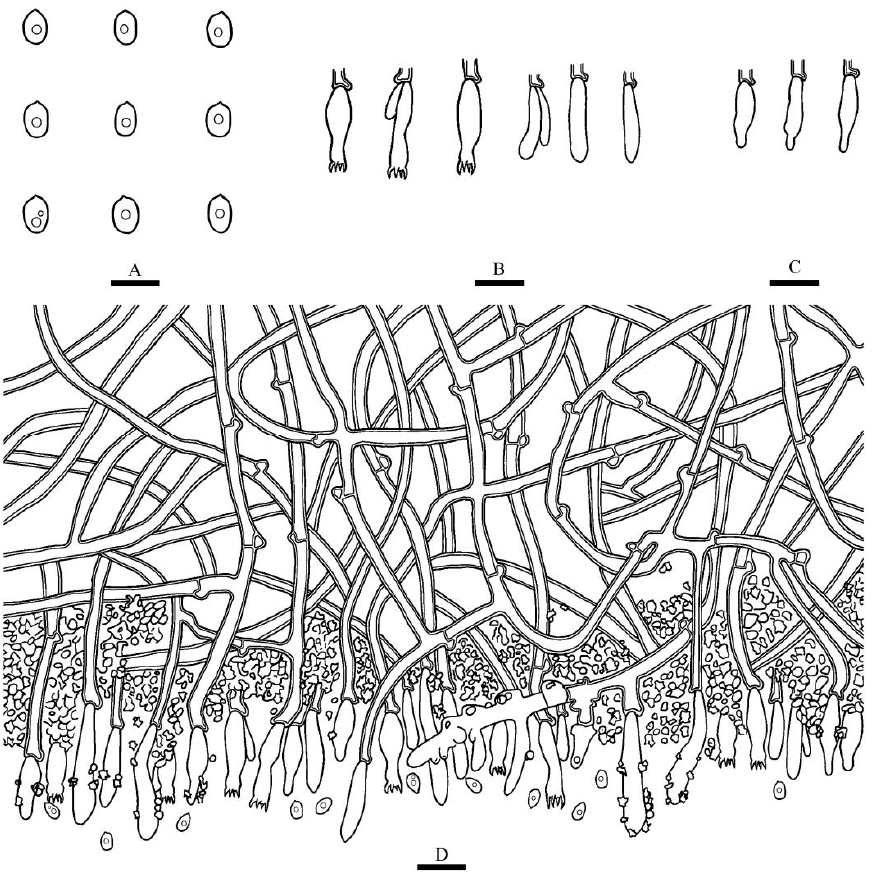
Figure 4. Microscopic structures of Xylodon grandineus (holotype): basidiospores ( A ), basidia and basidioles ( B ), subulate cystidia ( C ), a section of the hymenium ( D ). Bars: ( A ) = 5 µm, ( B – D ) = 10 µm.